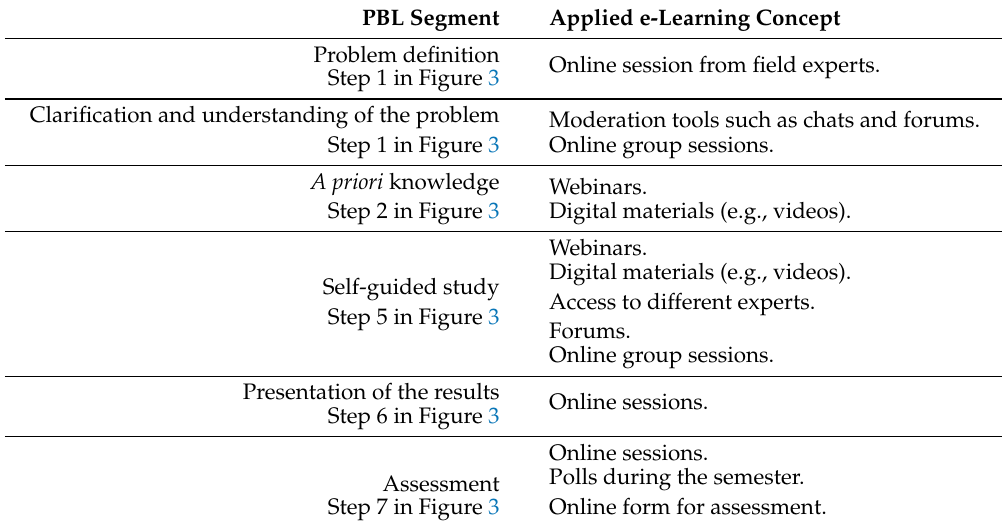
Table 7. How can e-learning enhance the PBL